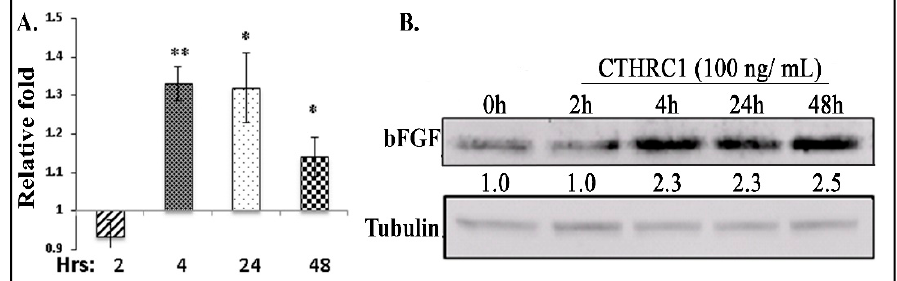
Figure 4. Effects of CTHRC1 in primary osteoblasts. Primary osteoblasts were treated with recombinant CTHRC1 or bFGF. CTHRC1 promoted bFGF expression at the mRNA level ( A ) and the protein level ( B ). The relative expression levels of mouse-specific bFGF at various time points were compared to the 0 h group using qRT-PCR ( n = 3). Whole-cell lysates were used for Western blots. Numbers under each blot were relative quantification of the densities normalized to tubulin. Experiments were repeated at least three times with the same results. * p ≤ 0.05, ** p ≤ 0.01, by Student’s t -test. More than six mice were used for collecting bone marrow.